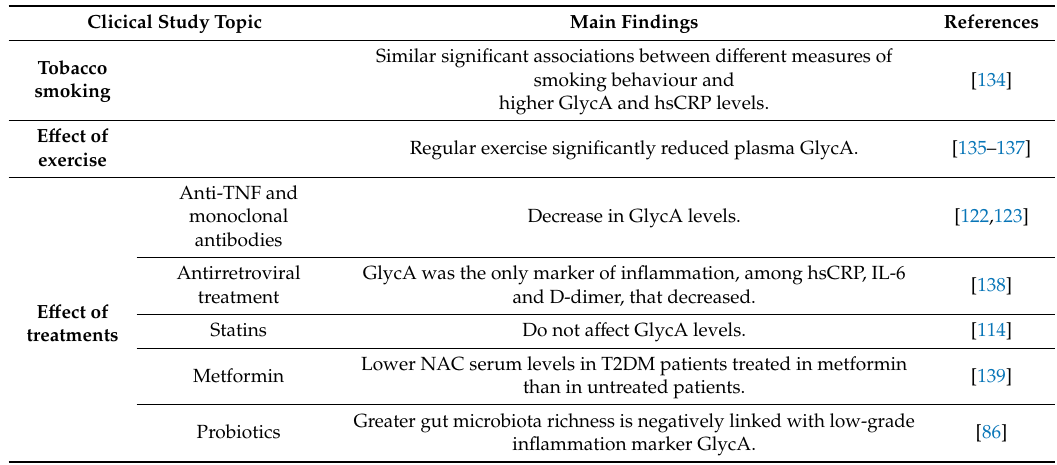
Table 3. Summary of 1 H-NMR glycoprotein’s clinical applications. (b) Treatment e ff ects and lifestyle.